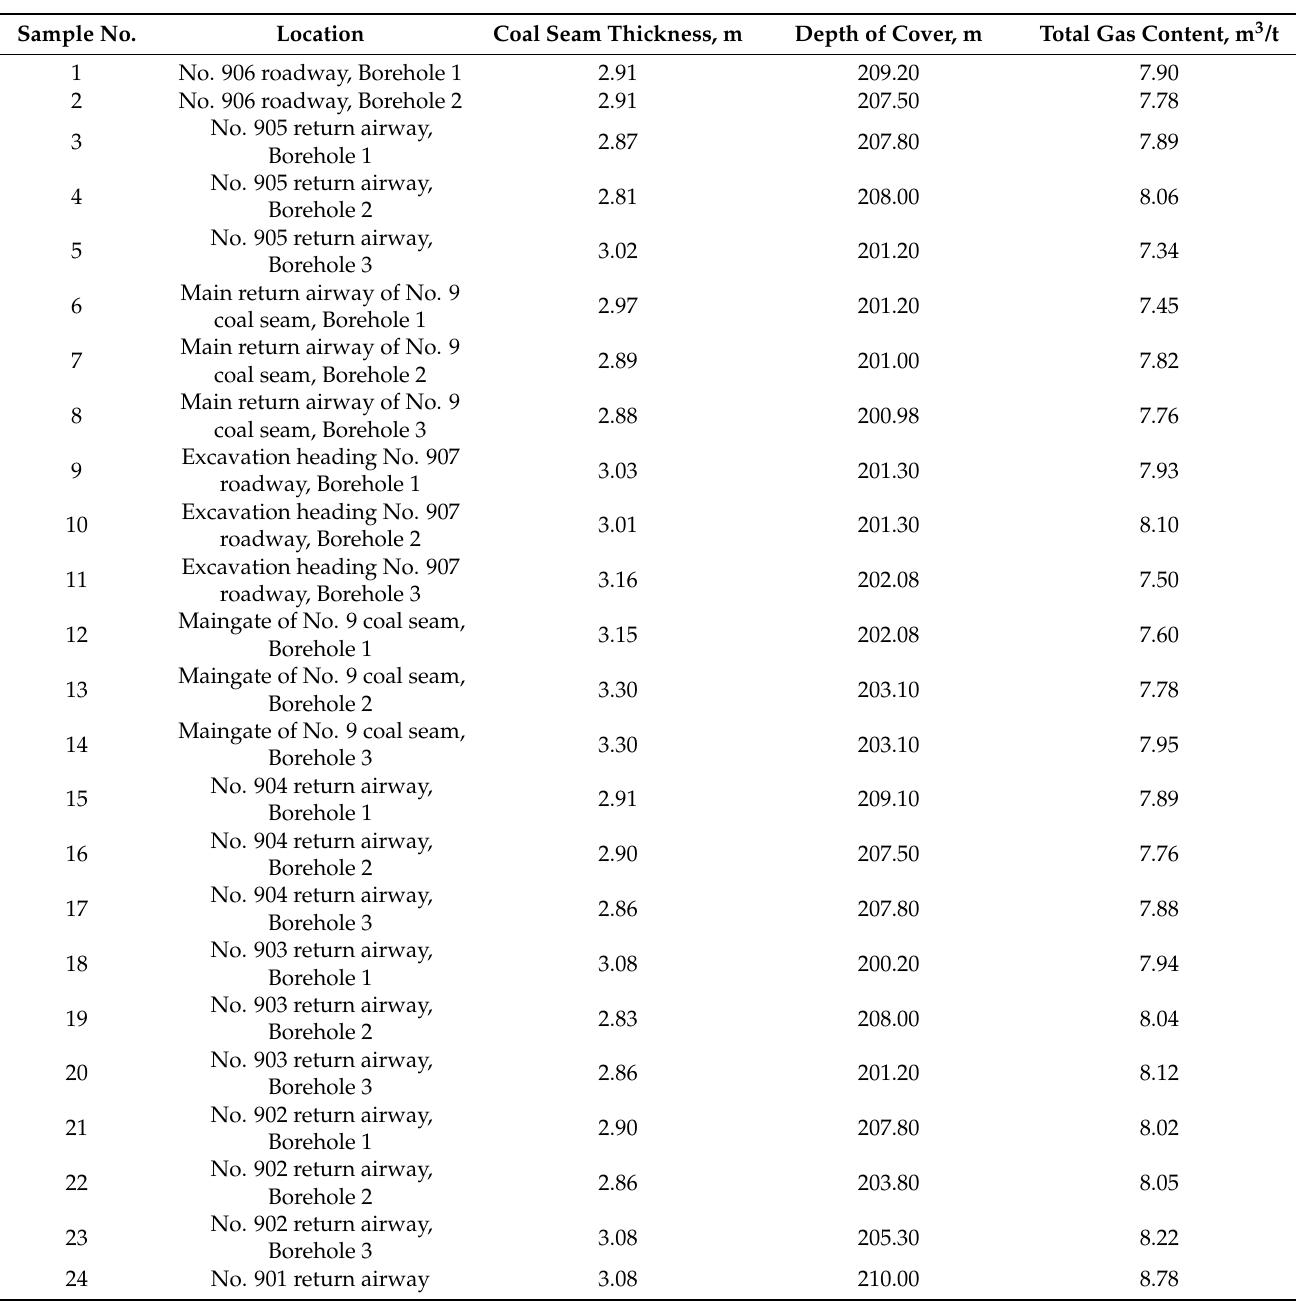
Table 2. Coal samples for gas content